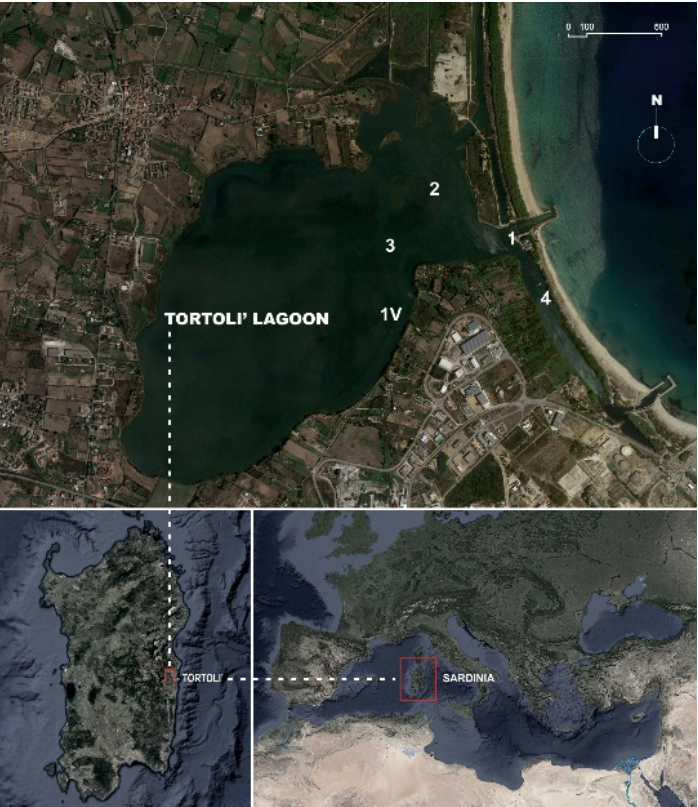
Figure 1. Study area and location of the sampling sites for harmful algal species and bivalve mollusks, from 2015 to 2020. 1, 2, 3, 4 and 1 V indicate sampling points (stations) in Tortolì Lagoon.